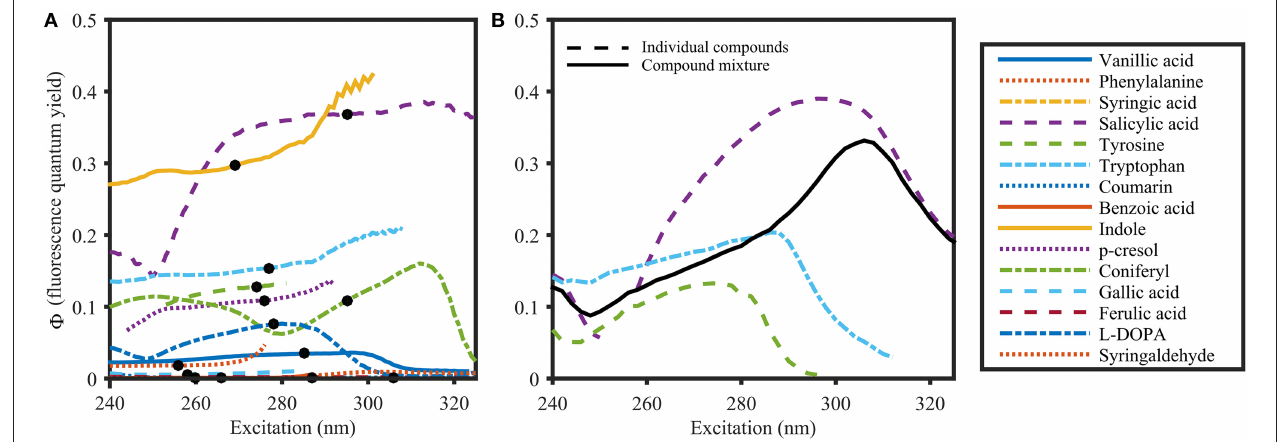
FIGURE 6 | 8 of organic compounds (A) and a compound mixture (B) dissolved in 1mmol L − 1 Phosphate buffer (pH 7.5). The solid black line in (B) represents 8 of the compound mixture. Dots in (A) represent the absorbance maximum of the respective compound. 8 was calculated using the variable-intercept approach ( R 2 > 0.95 and S/N >